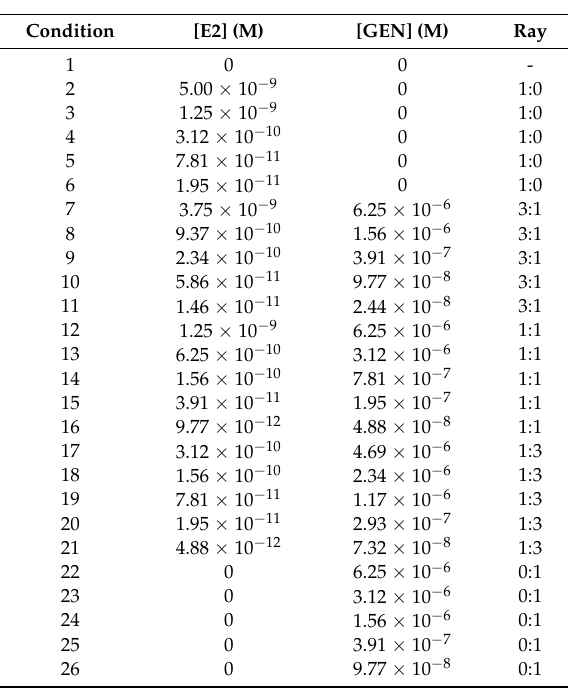
Table 1. Experimental ray design for the assessment of the effects of estradiol (E2) and genistein (GEN) alone and in mixtures on the expression of GFP in the brain of cyp19a1b -GFP transgenic zebrafish line.